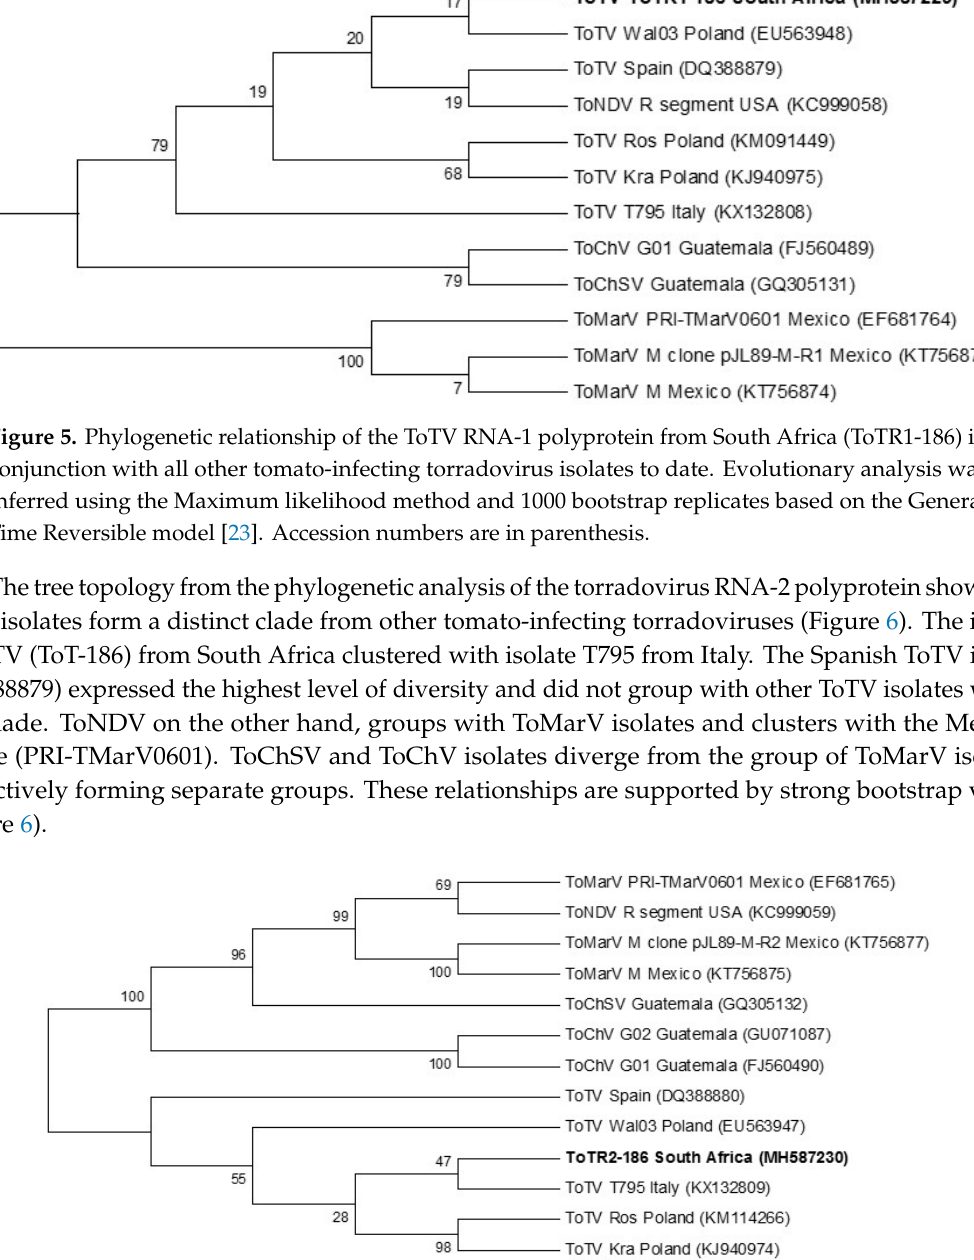
Figure 6. Phylogenetic relationship of the ToTV RNA-2 polyprotein from South Africa in conjunction with all other fully sequenced tomato-infecting torradovirus isolates to date. Evolutionary analysis was carried out in MEGA 6 using the Maximum likelihood method and 1000 bootstrap replicates based on the General Time Reversible model [23]. A gamma distribution rate ( g = 5) was used to model the evolutionary differences among sites. Accession numbers are in parenthesis.